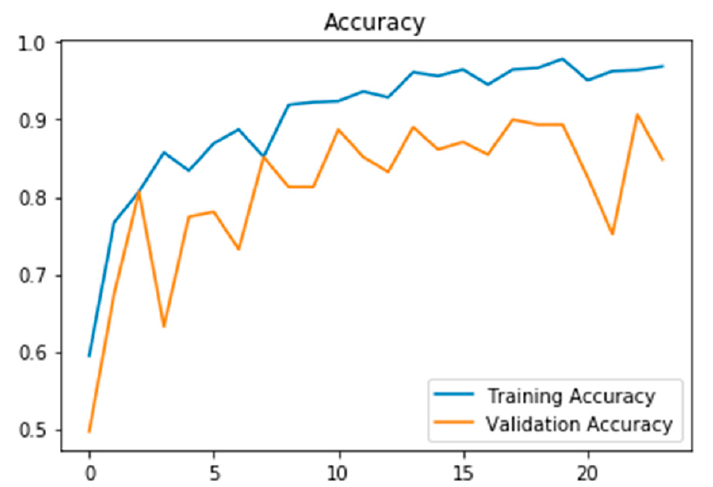
Figure 10. Training and validation accuracy showing the least gap between the accuracy values in training and validation sessions proves a good fit model.